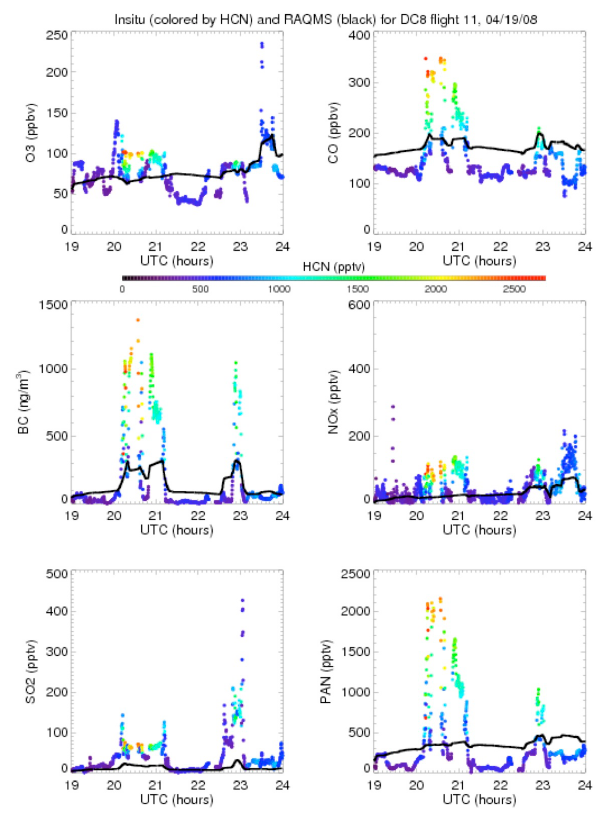
Figure 6: Ozone (O 3 ), Carbon monoxide (CO), Black Carbon (BC), Nitrogen Oxides (NO x ), Sulfur dioxide (SO2) and and Peroxyacetyl Nitrate (PAN) in situ measurement colored by Hydrogen Cyanide (HCN) concentrations as a function of UTC time during DC8 flight 11